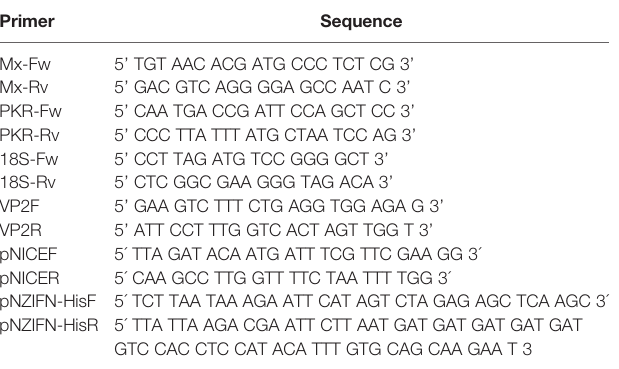
TABLE 1 | Primers used for PCR and RT-qPCR.